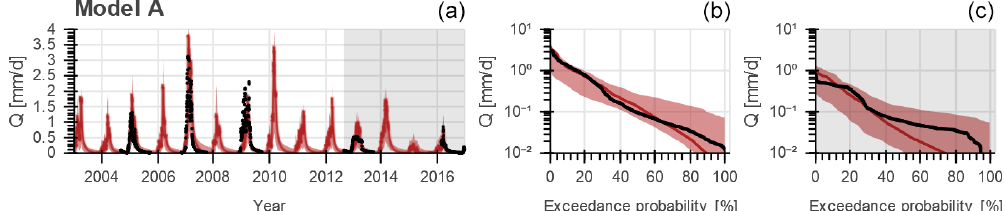
Figure 4. Range of model solutions for Model A. Panel (a) shows the hydrograph and (b, c) the flow duration curve of the recorded (black) and modelled discharge: the line indicates the solution with the highest calibration objective function with respect to discharge ( D E ,Q cal ) and the shaded area the envelope of the solutions retained as feasible. The data in the white area were used for calibration and the grey shaded area for